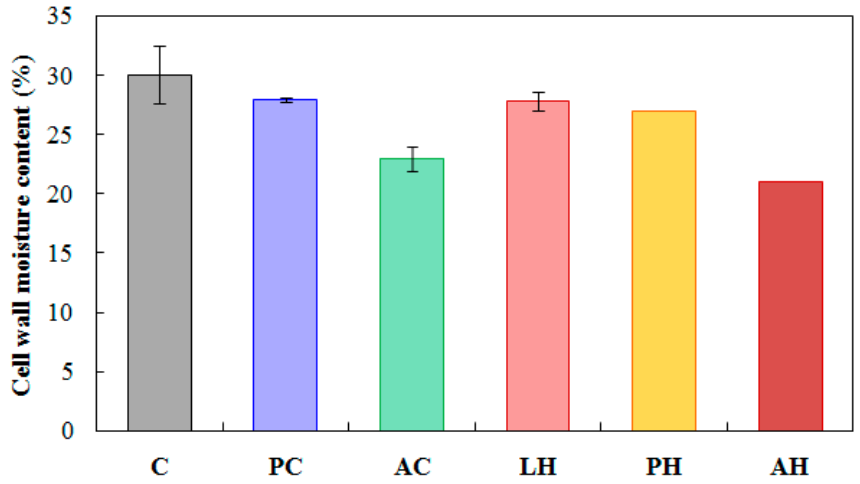
Figure 3. Cell wall moisture content in water-saturated control wood (C), pyridine-treated wood (PC), acetylated wood (AC), wood with low hemicelluloses (LH), pyridine-treated wood with low hemicelluloses (PH), and acetylated wood with low hemicelluloses (AH) analyzed by LFNMR.